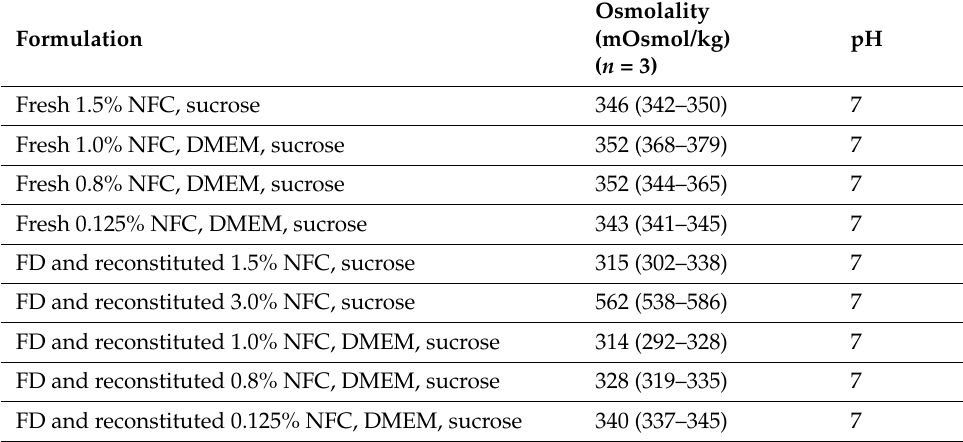
Table 1. The osmolalities in the form of average (range) and pH of fresh and freeze-dried and reconstituted nanofibrillated cellulose (NFC) hydrogels. FD: Freeze-dried. DMEM: Dulbecco’s modified eagle